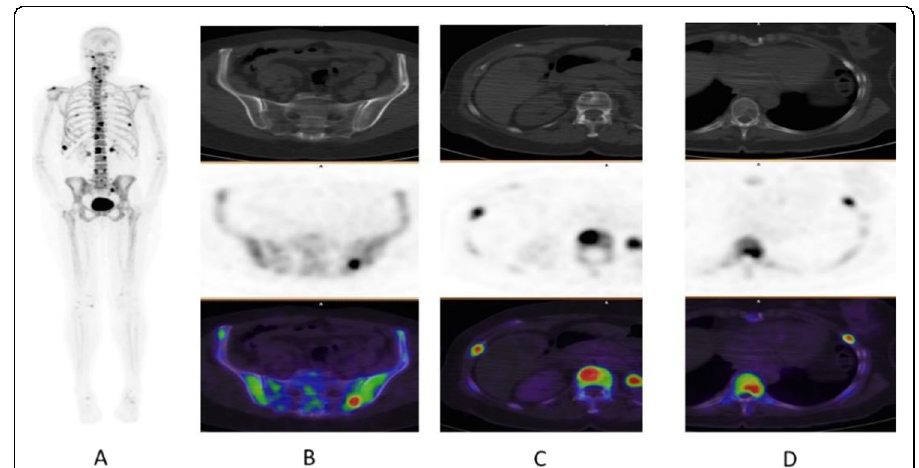
Fig. 70 18 F-NaF, breast cancer staging. Clinical history : 55 y.o. woman recently diagnosed with breast cancer (ductal adenocarcinoma, ER+, PR, and HER2 neg), asymptomatic. PET/CT findings : multiple foci of increased tracer uptake consistent with skeletal metastatic spread ( a MIP). Note the heterogeneity of the CT